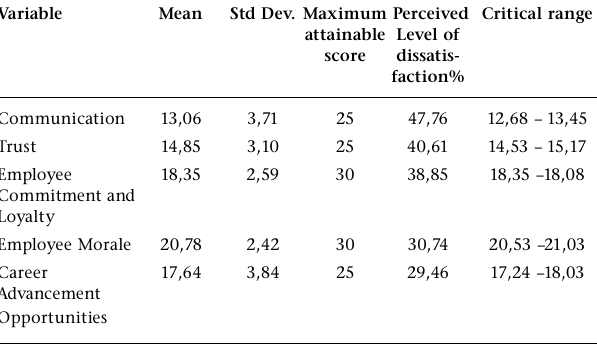
Table 2 indicates that the process of downsizing and transformation was perceived by survivors as impacting on the variables of the study in varying degrees. The greatest area of dissatisfaction/impact was with communication (47,76%), followed by trust (40,61%), commitment and loyalty (38,85%), morale (30.74%) and then, perceived career advancement opportunities